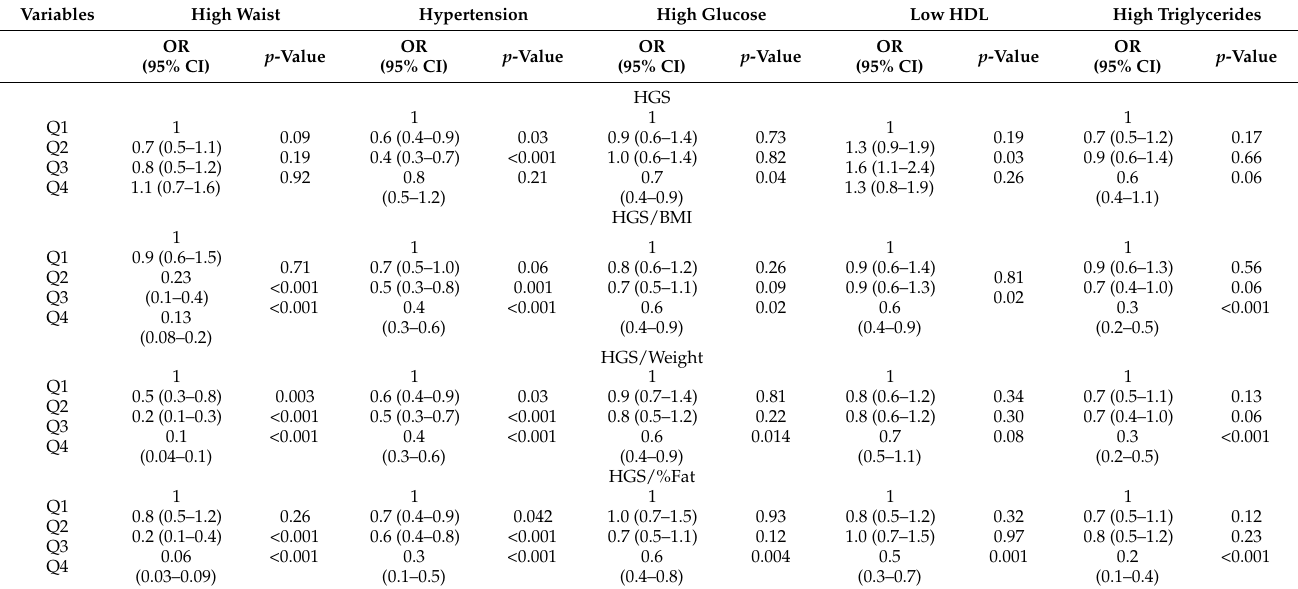
Table 5. Odds ratio of each quartile of handgrip strength, handgrip strength relative to body mass index, handgrip strength relative to weight, and handgrip strength relative to body fat percentage for metabolic syndrome